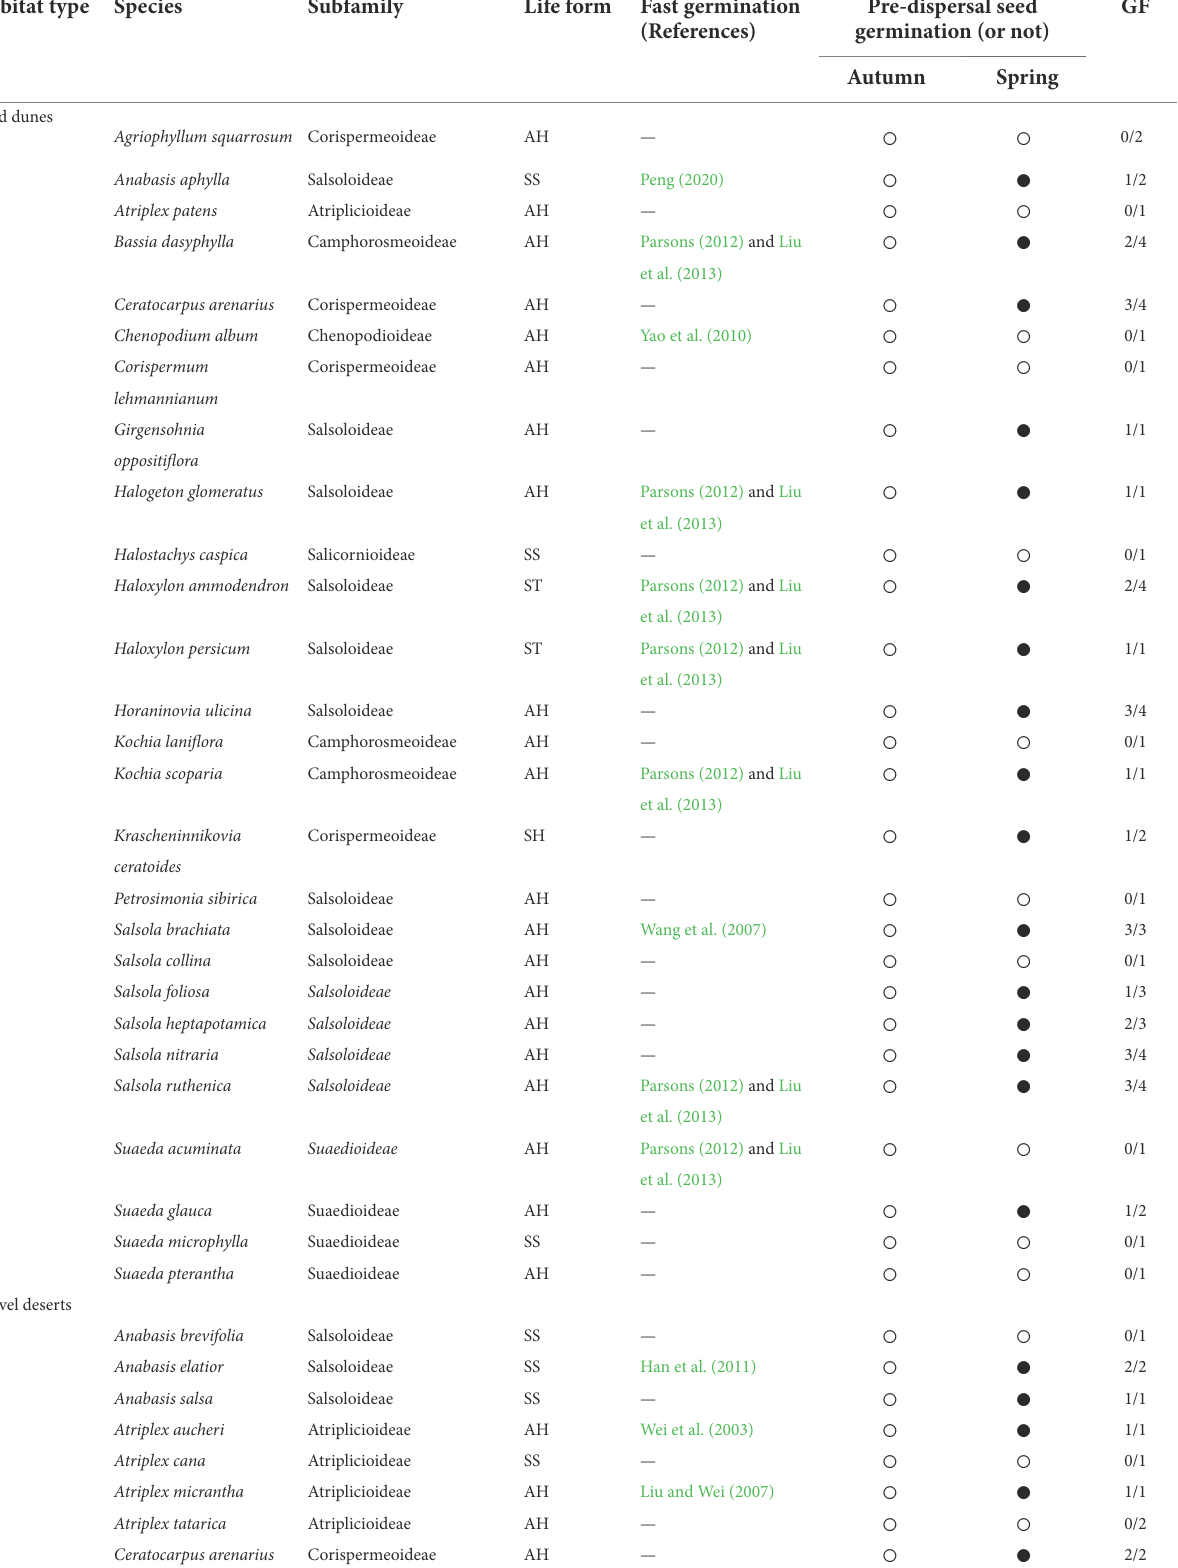
TABLE 1 Pre-dispersal seed germination (or not) in Amaranthaceae species (in various subfamilies of Amaranthaceae) in the cold deserts of northern Xinjiang in both autumn 2021 and spring 2022 and reports in the literature of very fast germination occurring in the species of Amaranthaceae surveyed in this